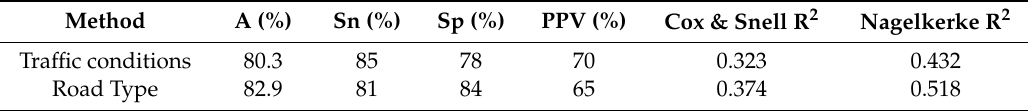
Table 7. Comparison of two developed